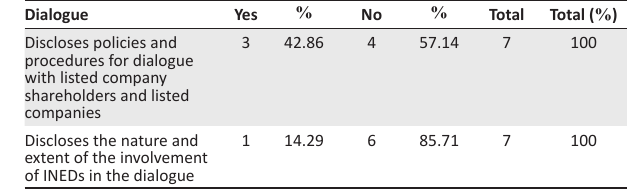
TABLE 7: Findings on the dialogue